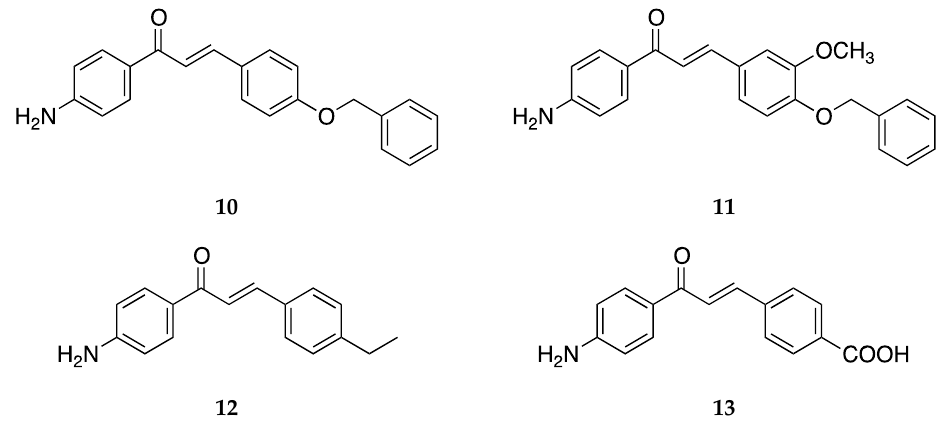
Figure 12. Chemical structures of 4-aminochalcone derivatives.